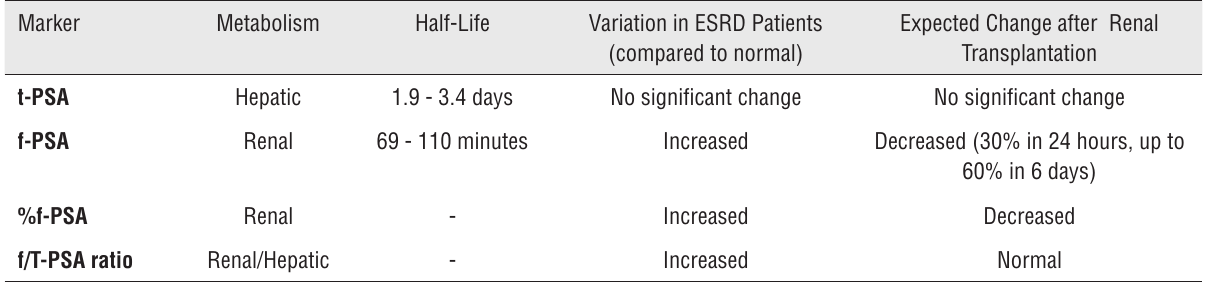
Table 2 - psA Kinetics in Renal Transplant Recipients